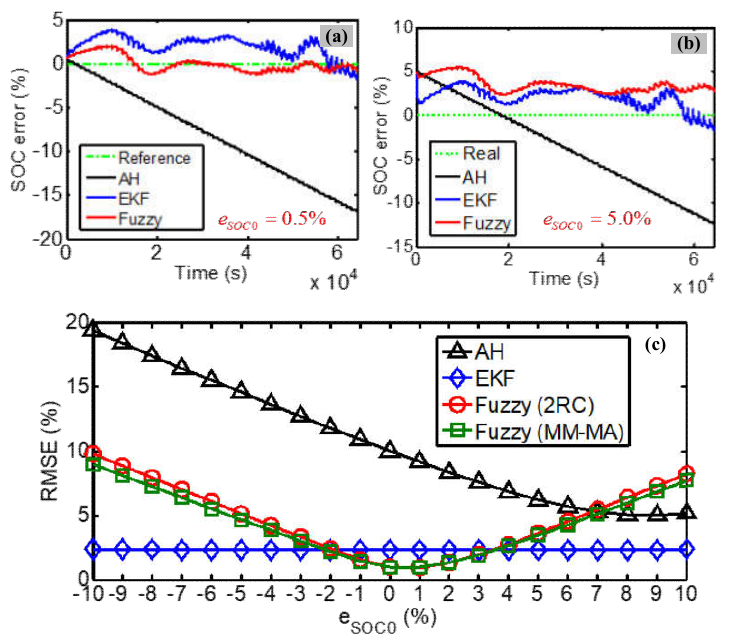
Figure 12. SOC estimation results for Case A. ( a ) e SOC 0 = 0.5%; ( b ) e SOC 0 = 5.0%; and ( c ) root-mean-square error (RMSE) of SOC in different initial SOC errors.